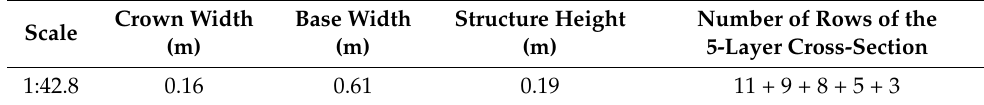
Table 1. Geometric parameters of the Cubipod